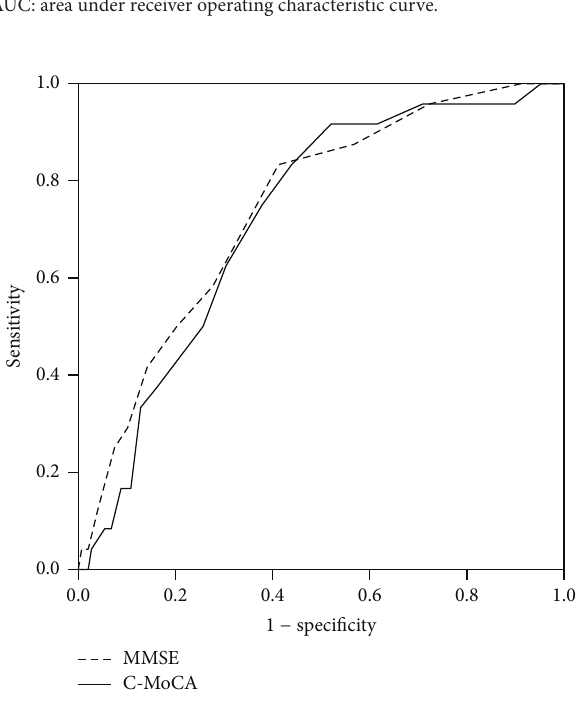
Figure 1: Receiver operating characteristic curve of MMSE and C- MoCA. The ROC curves were used to detect the amnesic MCI. C-MoCA: the Chinese version of Montreal cognitive assessment. MMSE: mini-mental state